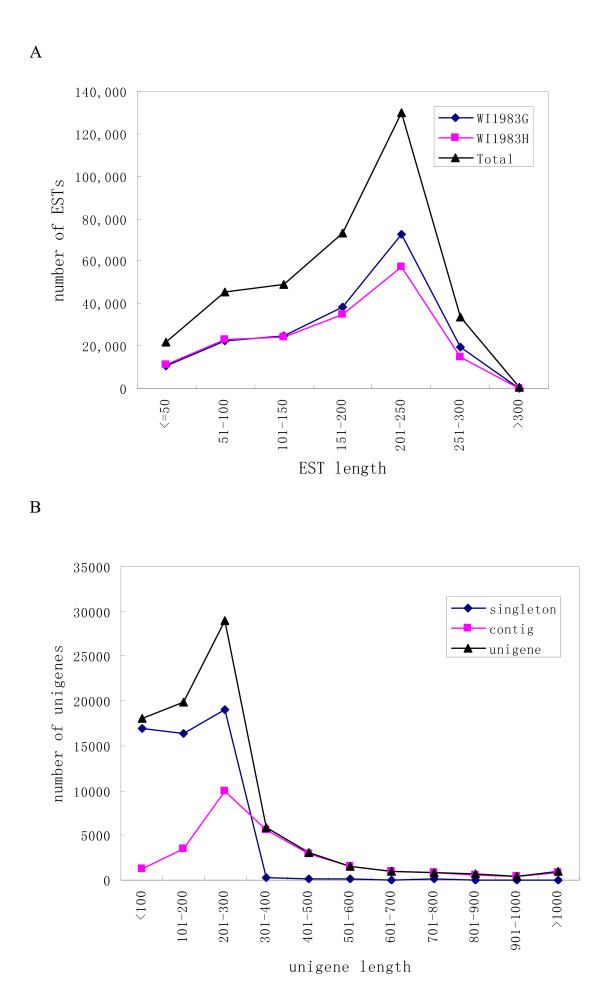
Length distributions of cucumber ESTs (A) and assembled sequences (B).